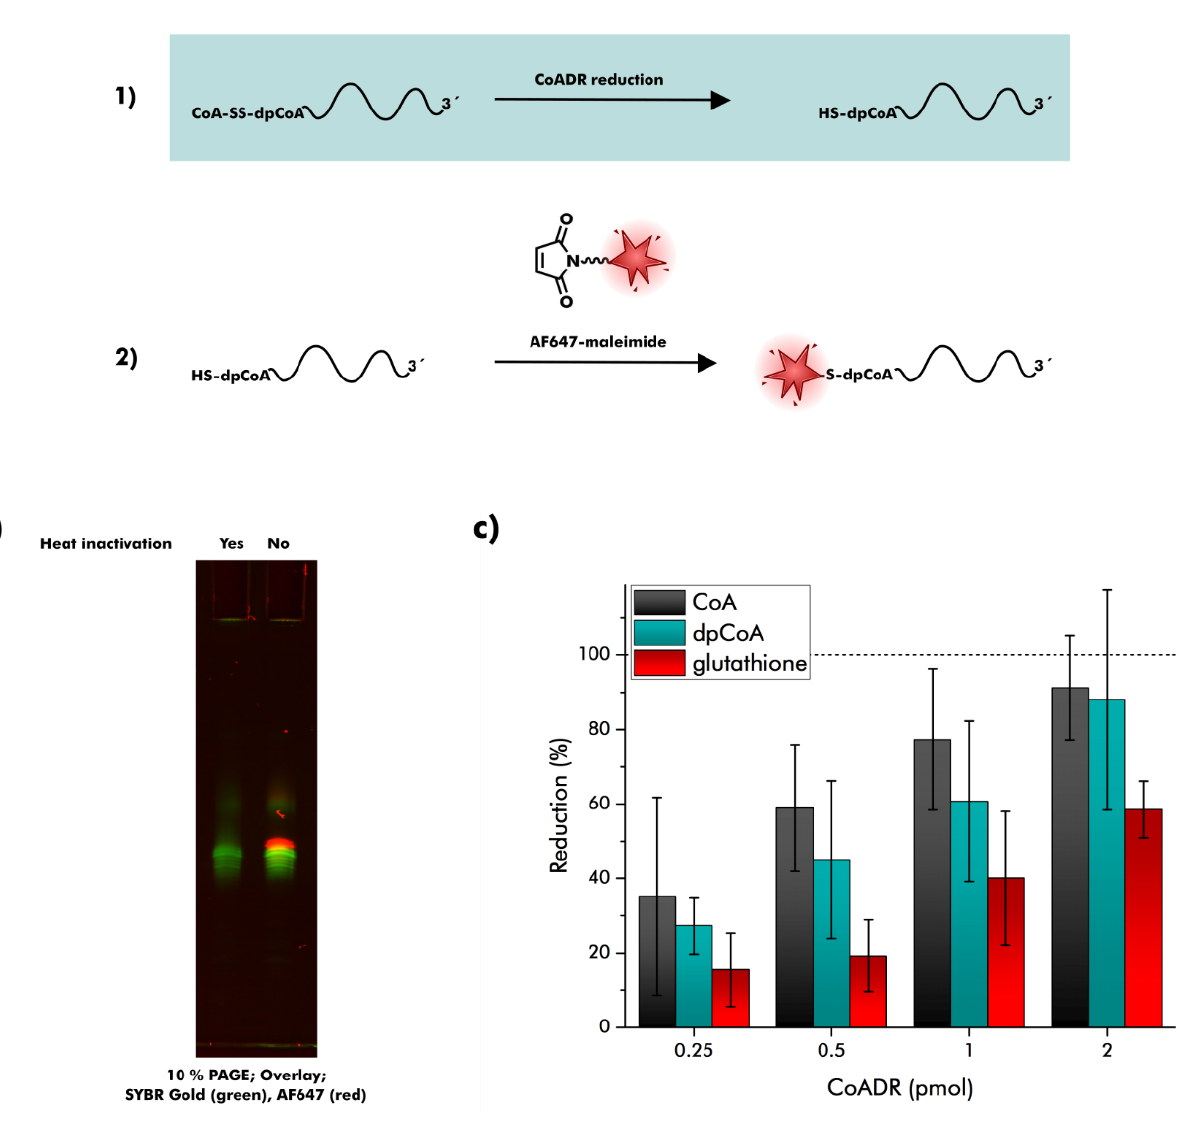
Figure 4. Reduction of dpCoA-RNA disulfides by S. aureus CoADR. ( a ) Schematic overview. (1) dpCoA-RNA disulfides were treated with S. aureus CoADR. (2) Originating dpCoA-RNAs were visualized with Alexa Fluor 647-maleimide (AF647-maleimide). ( b ) CoA-SS-dpCoA-RNA was incubated with either heat-inactivated or active S. aureus CoADR, then treated with AF647-maleimide. RNA was stained with SYBR Gold after 10% PAGE. AF647 signals (red) and SYBR Gold signals (green) were superimposed. ( c ) dpCoA-RNA disulfides with CoA, dpCoA and glutathione were incubated with defined concentrations of S. aureus CoADR or TCEP for 1 h, then treated with AF647-maleimide. AF647 signals were quantified after 10% PAGE. Gel segments with AF647 signals are shown in the supporting information (Figure S6). AF647 signal intensities were normalized to TCEP treatment (100% reduction). Error bars represent the standard deviation (n = 3).